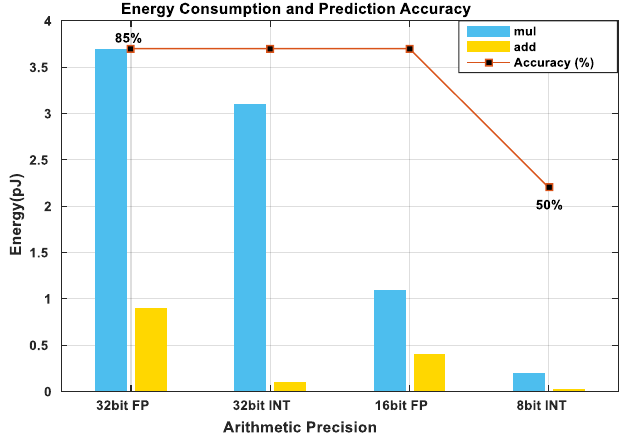
Figure 3. This graph describes the energy consumption and prediction accuracy of a DNN as a function of the Arithmetic Precision adopted for a single MAC unit in a 45 nm CMOS [124]. It may be deduced from the graph that lower number precisions consume less power than high precisions with no loss in prediction accuracy. However, we can observe that when precision is reduced below a particular threshold (16 bit fp), the accuracy of the model is greatly affected. Thus, quantization may be performed successfully to conserve energy but quantizing below 16-bit fp may require retraining and fine-tuning to restore the accuracy of the